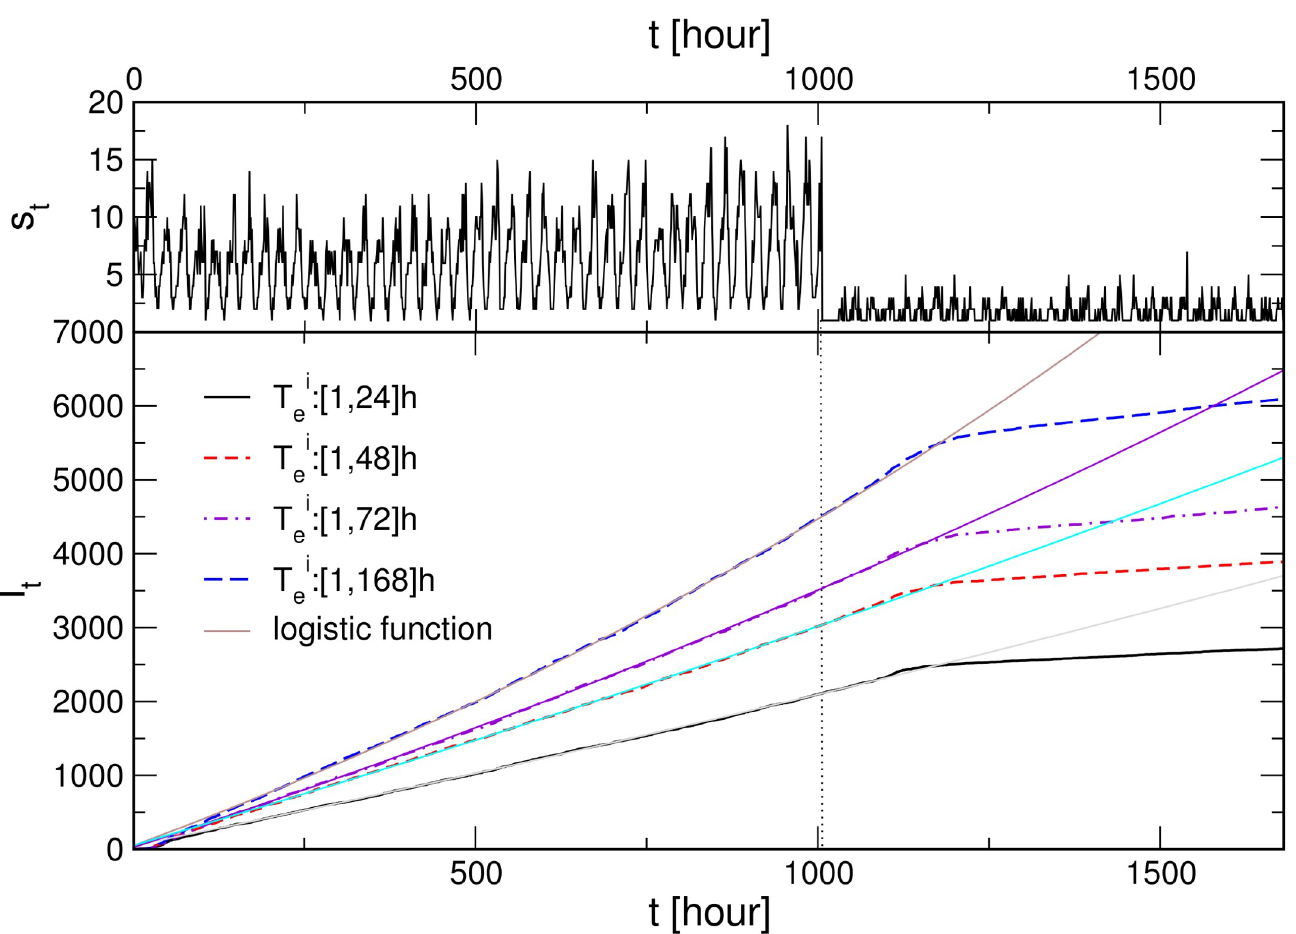
Fig 5. Moderate social dynamics with a lockdown. The fluctuations of social activity s range of exposure times, indicated in the legend (bottom), for the case with virus mutations.